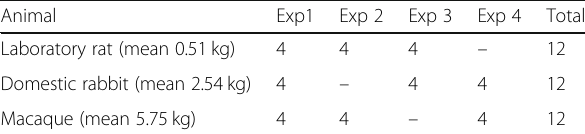
Table 1 Number of animals used in each round of the experiment